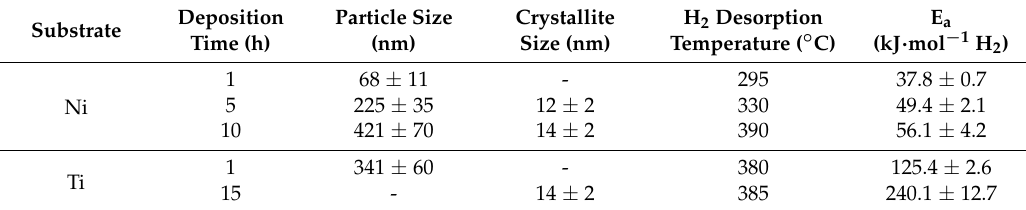
Figure 2. ( a ) Photo and typical SEM images of the pristine Ni foam; and typical SEM images and particle-size distribution of the magnesium nanoparticles obtained at different deposition times ( b ) 1 h; ( c ) 5 h; and ( d ) 10 h of di- n -butylmagnesium at the Ni surface. Table 1. Summary of the physical and hydrogen desorption properties of the magnesium nanoparticles deposited on Ni and Ti. Particle size was determined by SEM, crystallite size by the Scherrer equation, and activation energy (E a ) by using the Kissinger method.